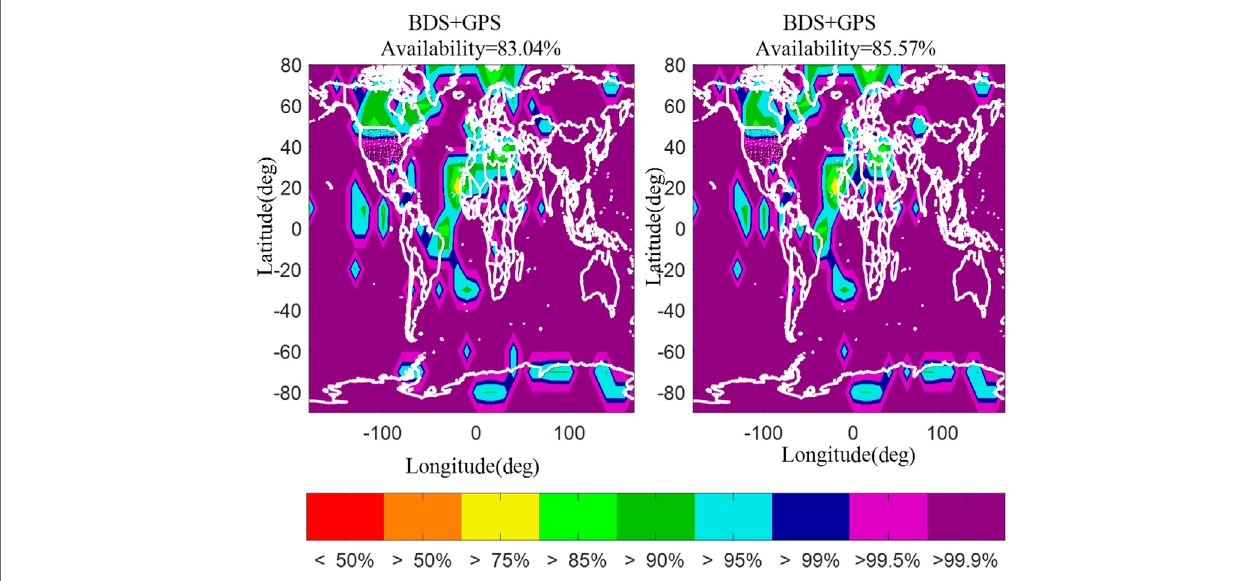
FIGURE 6 | Availability before and after dual-constellation optimization under the condition of VAL = 35